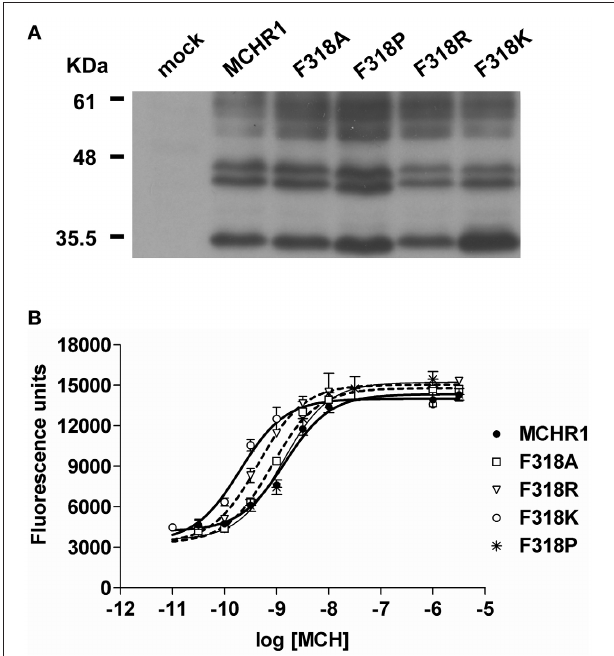
FIGURE 2 | Analysis of the effects of substitution mutations of the highly conserved Phe318 in the MCHR1 NPxxY(x) 5 , 6 F motif on receptor function in HEK293T cells. (A) Protein expression of Flag-MCHR1 and mutant receptors. After lysis of transfected cells with SDS-sample buffer, 15 μ g total protein were separated by 15% SDS-PAGE, transferred to a polyvinyl difluoride membrane, and immunoblotted with an anti-Flag M2 antibody. Four major immunoreactive bands of 35, 44, 45, and 60kDa are present in Flag-MCHR1 and individual mutant receptors. (B) Dose-response relationship of MCH-stimulated calcium influx in HEK293T cells expressing Flag-MCHR1 or mutant receptors. Cells transfected with Flag-MCHR1 or the substitution mutant receptors were stimulated with the indicated concentrations of MCH, and the subsequent changes in cytoplasmic free Ca 2 + levels were measured using a FlexStation. Results shown are representative of at least three-independentexperiments.